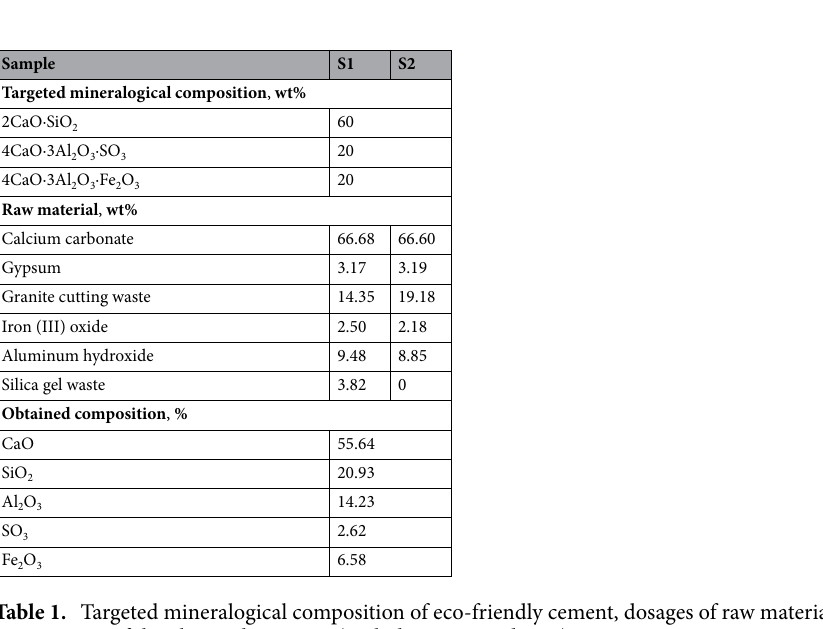
Figure 2. XRD pattern of granite cutting waste. Indexes: An-annite; Ac-actinolite; z-microcline; x-albite; Q-quartz; n-anorthite, l-labradorite.